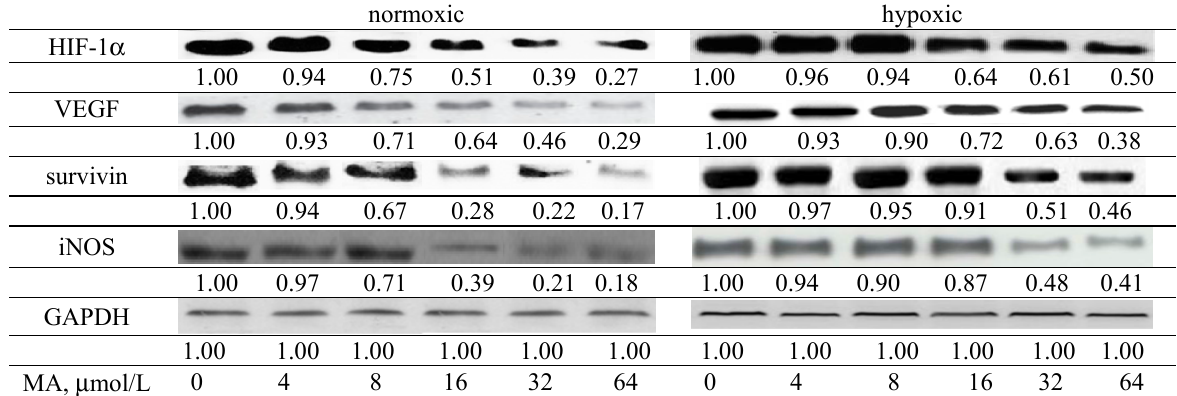
Figure 6. Effects of MA at 0, 4, 8, 16, 32 or 64 μ mol/L upon HIF-1 α , VEGF, survivin and iNOS expression in A549 cells under normoxic and hypoxic conditions. Data are mean ± SD ( n = 10).